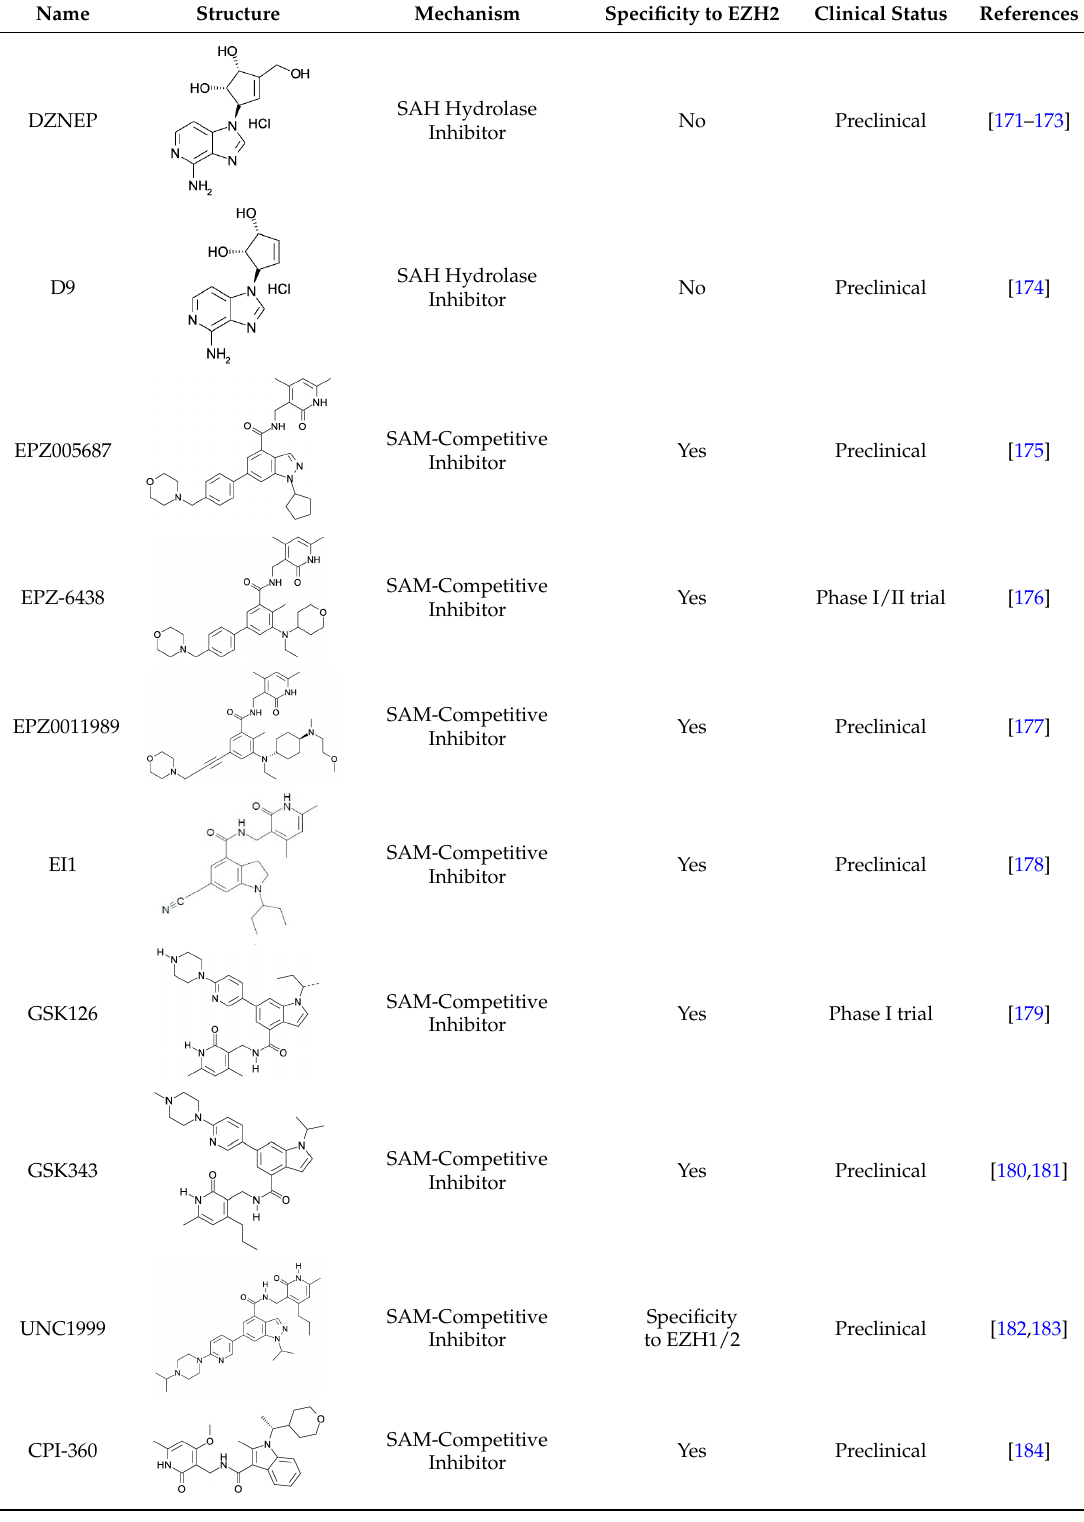
Table 1. Inhibitors developed against EZH2.